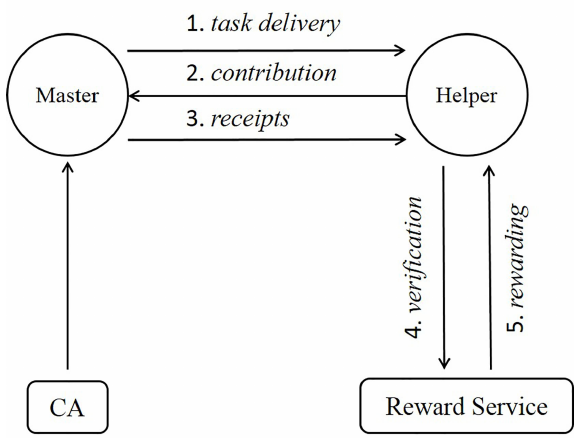
Figure 1. System